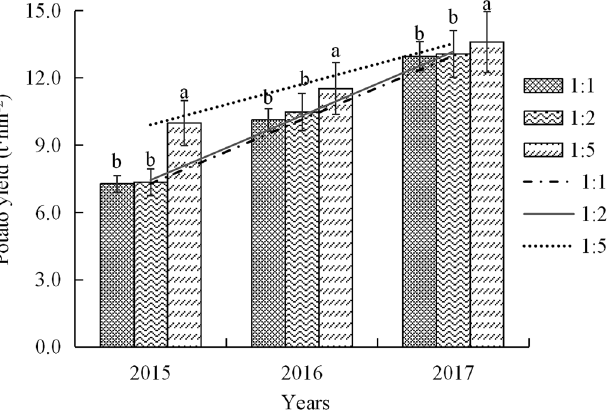
Figure 5. Potato yield in compound soil under different planting years. Lowercase letters indicate differences in 5% levels of different compound soils under the same planting